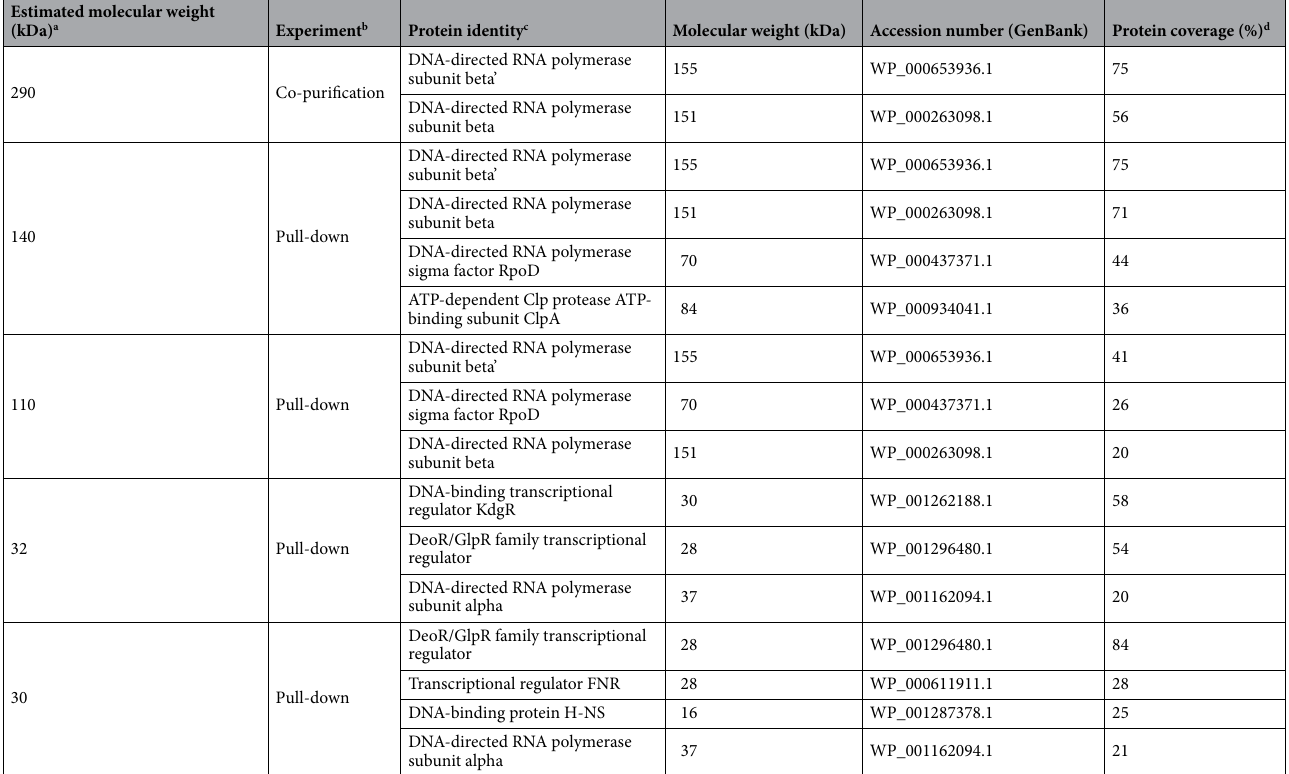
Table 2. Summary of identified proteins interacting with MBP-PerA. Complete dataset is in Supplementary file 1. a Estimated by mobility in the SDS-PAGE and compared with the molecular weight marker. b Indicates from which experiments the analyzed band comes from. c Protein identification was carried out by the Proteomics facility using the E. coli protein database (see the Methods section for details). d The number indicates percentage of coverage of the corresponding protein with the identified